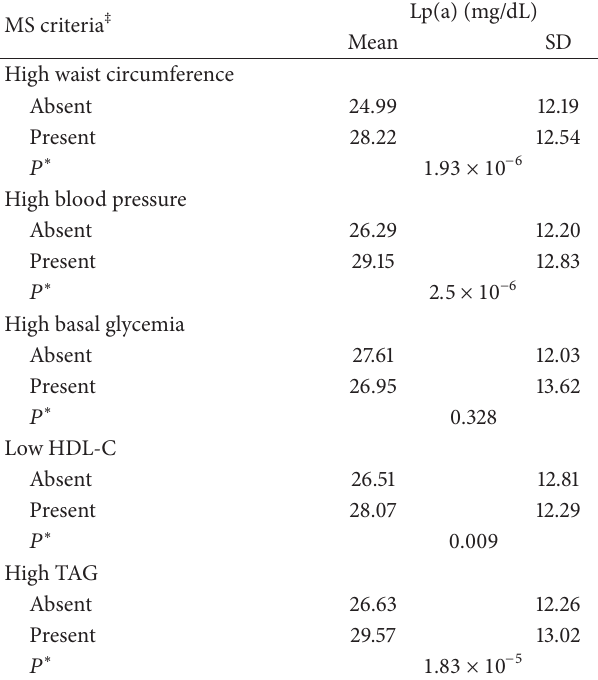
Table 4: Serum Lp(a) concentration assessed by criteria for the metabolic syndrome. The Maracaibo City Metabolic Syndrome Prevalence Study,